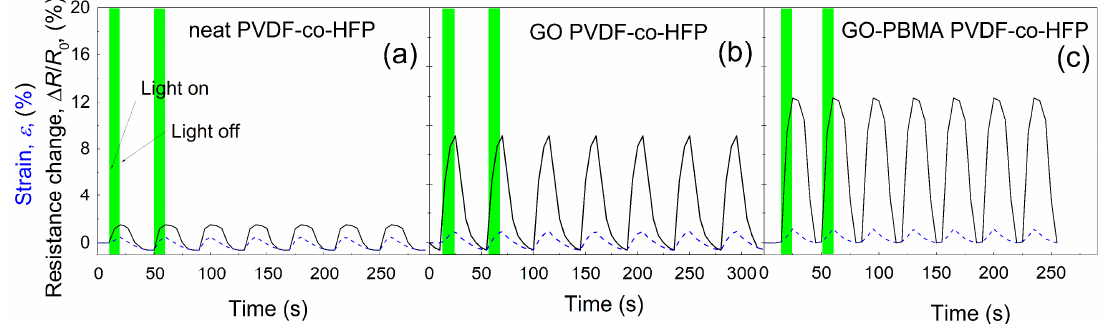
Figure 8. Light-induced actuation strain (dashed blue lines) and resistance change of non-woven electrospun mats (solid black line) at a light intensity of 6 mW for neat PVDF- co -HFP ( a ), GO PVDF- co -HFP ( b ) and GO-PBMA PVDF- co -HFP ( c ).